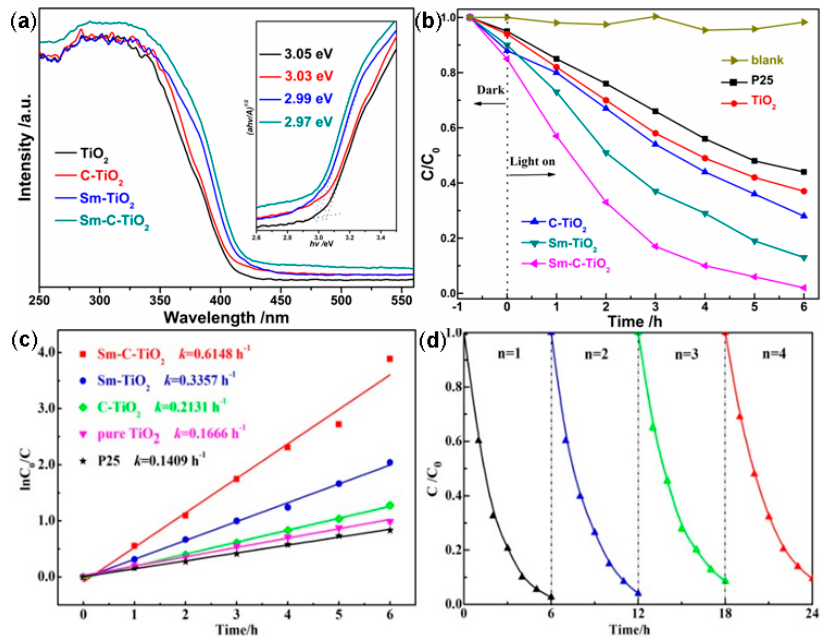
Figure 5. ( a ) Diffusive reflectance UV-Visible absorption profiles of the samples of pure TiO 2 , C-TiO 2 , Sm-TiO 2 , and Sm-C-TiO 2 , inset shows the corresponding Tauc plots as well as the optical band gap values for the undoped and doped TiO 2 . The time course ( b ) and kinetic curves ( c ) of MB photodegradation over different samples under visible light irradiation.(P25; pure TiO 2 ; Sm-TiO 2 ; C-TiO 2 ; Sm-C-TiO 2 ). ( d ) Cycling runs in photocatalytic degradation of MB in the presence of Sm-C-TiO 2 photocatalysts under visible light irradiation.